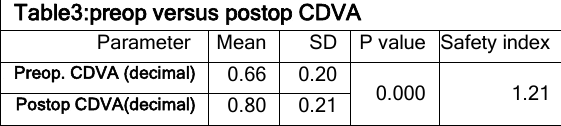
Table 2: pre op CDVA versus postop UDVA